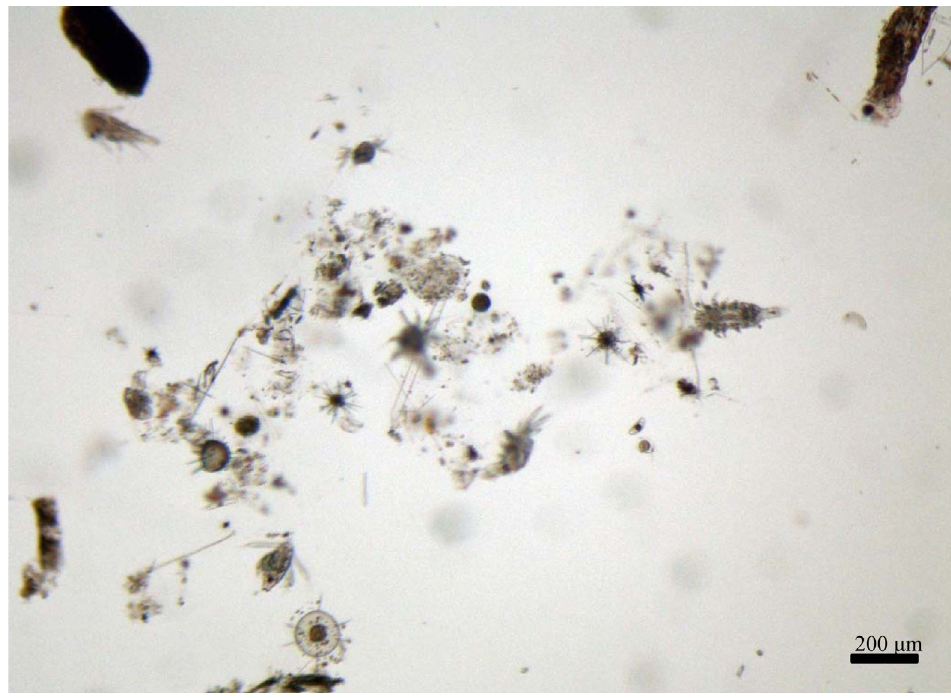
Fig. 3. Zoo- and phytoplanktons and amorphous materials observed in POMEW sample fi ltered through 350 m m mesh in 2013 cruise.